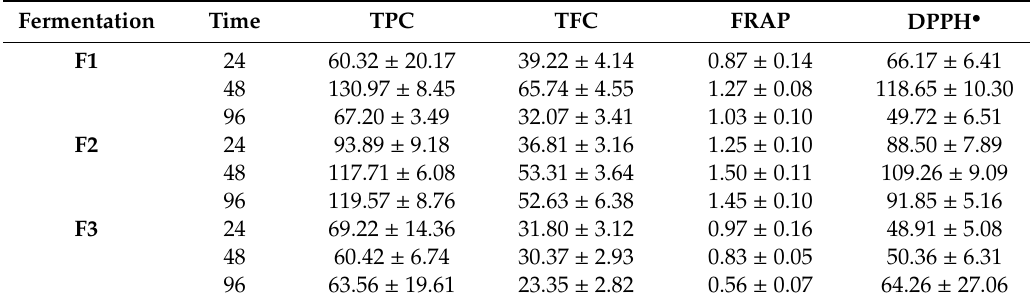
Experiment 1: cowpea-beans flours fermented under conditions of 30% of moisture.TPC—expressed as µ g of gallic acid equivalents (GAE) / 100 mg of flour dry matter (DM); TFC— µ g of catechin equivalents (CAE) / 100 mg of flour DM; FRAP— µ mol ferrous sulphate equivalents (FSE) / 100 mg of flour DM; DPPH • - µ g of trolox equivalents (TE) / 100 mg of flour